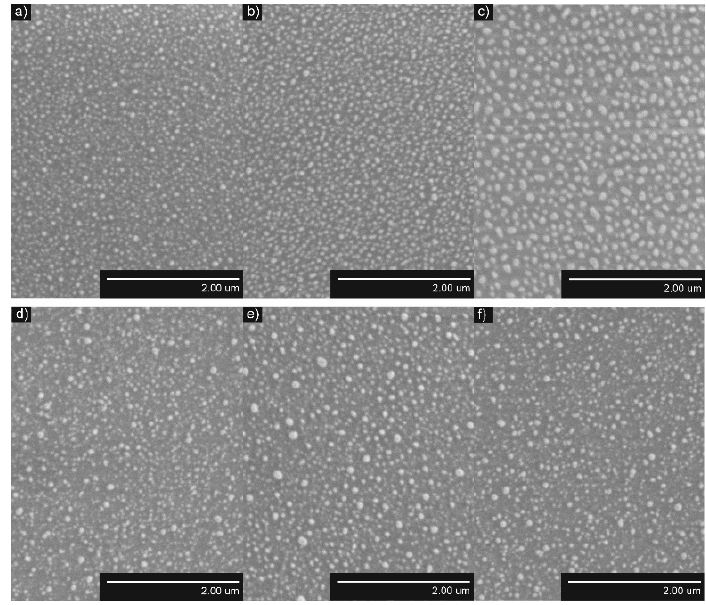
Figure 5. SEM images of AgNP after annealing ( T a = 400 °C) of Ag/TiO 2 thin films system: ( a ) h = 5 nm, as-deposited TiO 2 ; ( b ) h = 7.5 nm, as-deposited TiO 2 ; ( c ) h = 10 nm, as-deposited TiO 2 ; ( d ) h = 5 nm, T TiO2 = 500 °C; ( e ) h = 7.5 nm, T TiO2 = 500 °C; ( f ) h = 10 nm, T TiO2 = 500 °C. Similar results were obtained for AgNP. D mean of AgNP increased from 45.2 nm to 86.0 nm for the Ti20 group samples and from 47.7 nm to 50.4 nm for the Ti500 group samples when annealing thicker Ag films. The same dependence was observed for NND avg of AgNP. It increased from 31.4 nm to 38.3 nm for the Ti20 group and from 33.7 nm to 37.8 nm for the Ti500 group. The density of AgNP decreased from 85.8 μm −2 to 39.2 μm −2 for the Ti20 group and from 62.8 μm −2 to 54.9 μm −2 for the Ti500 group when annealing thicker